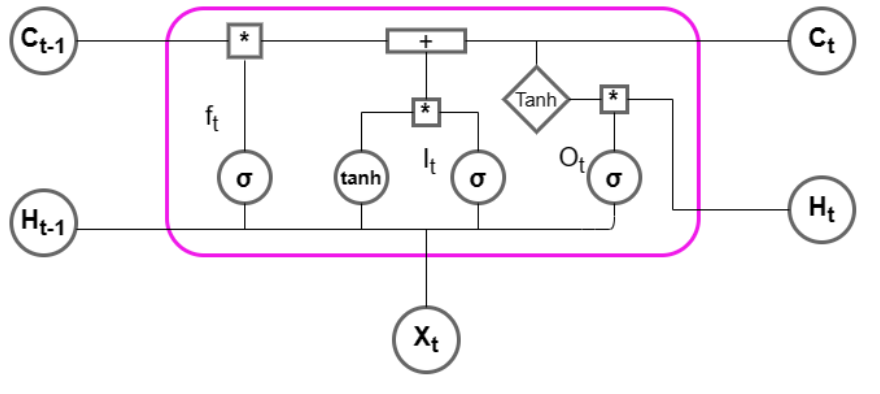
Figure 1. LSTM network